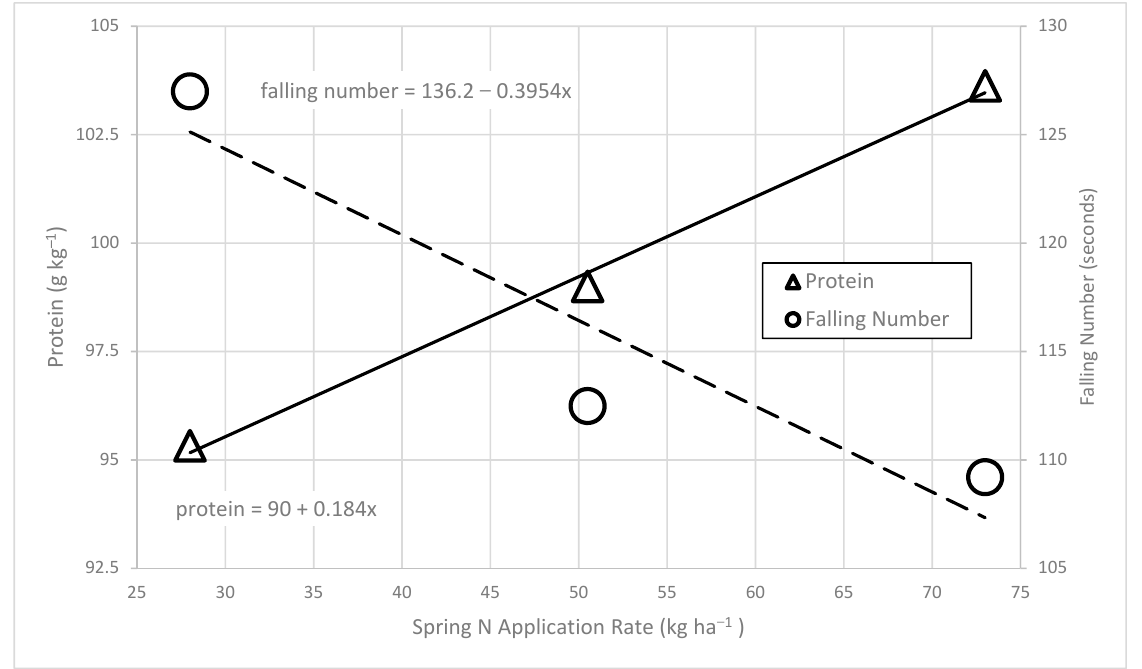
Figure 4. Protein content (g kg − 1 dry matter) and falling number (seconds) as a function of spring N application (kg ha − 1 ).